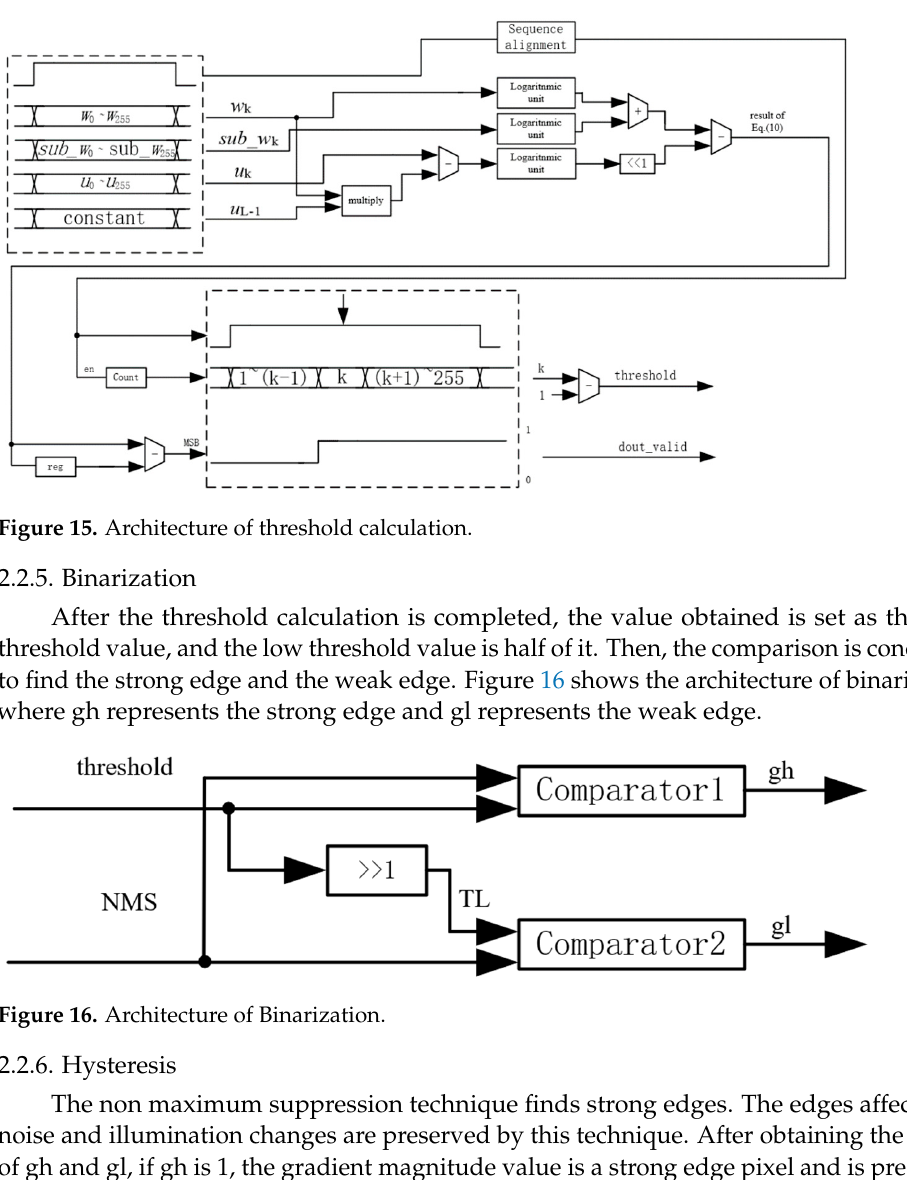
11 of 17 Figure 14. Architecture of logarithmic converter. (d) Threshold calculation